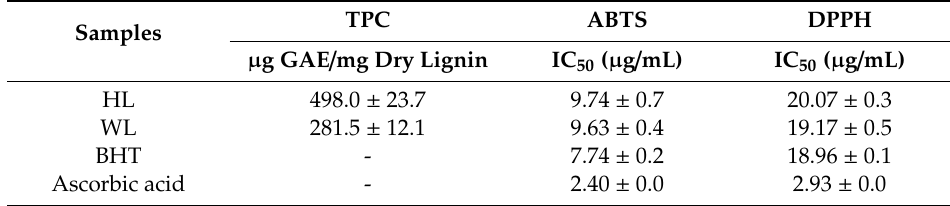
Table 5. Total phenolic content (TPC) and antiradical properties of isolated lignins determined by DPPH and ABTS